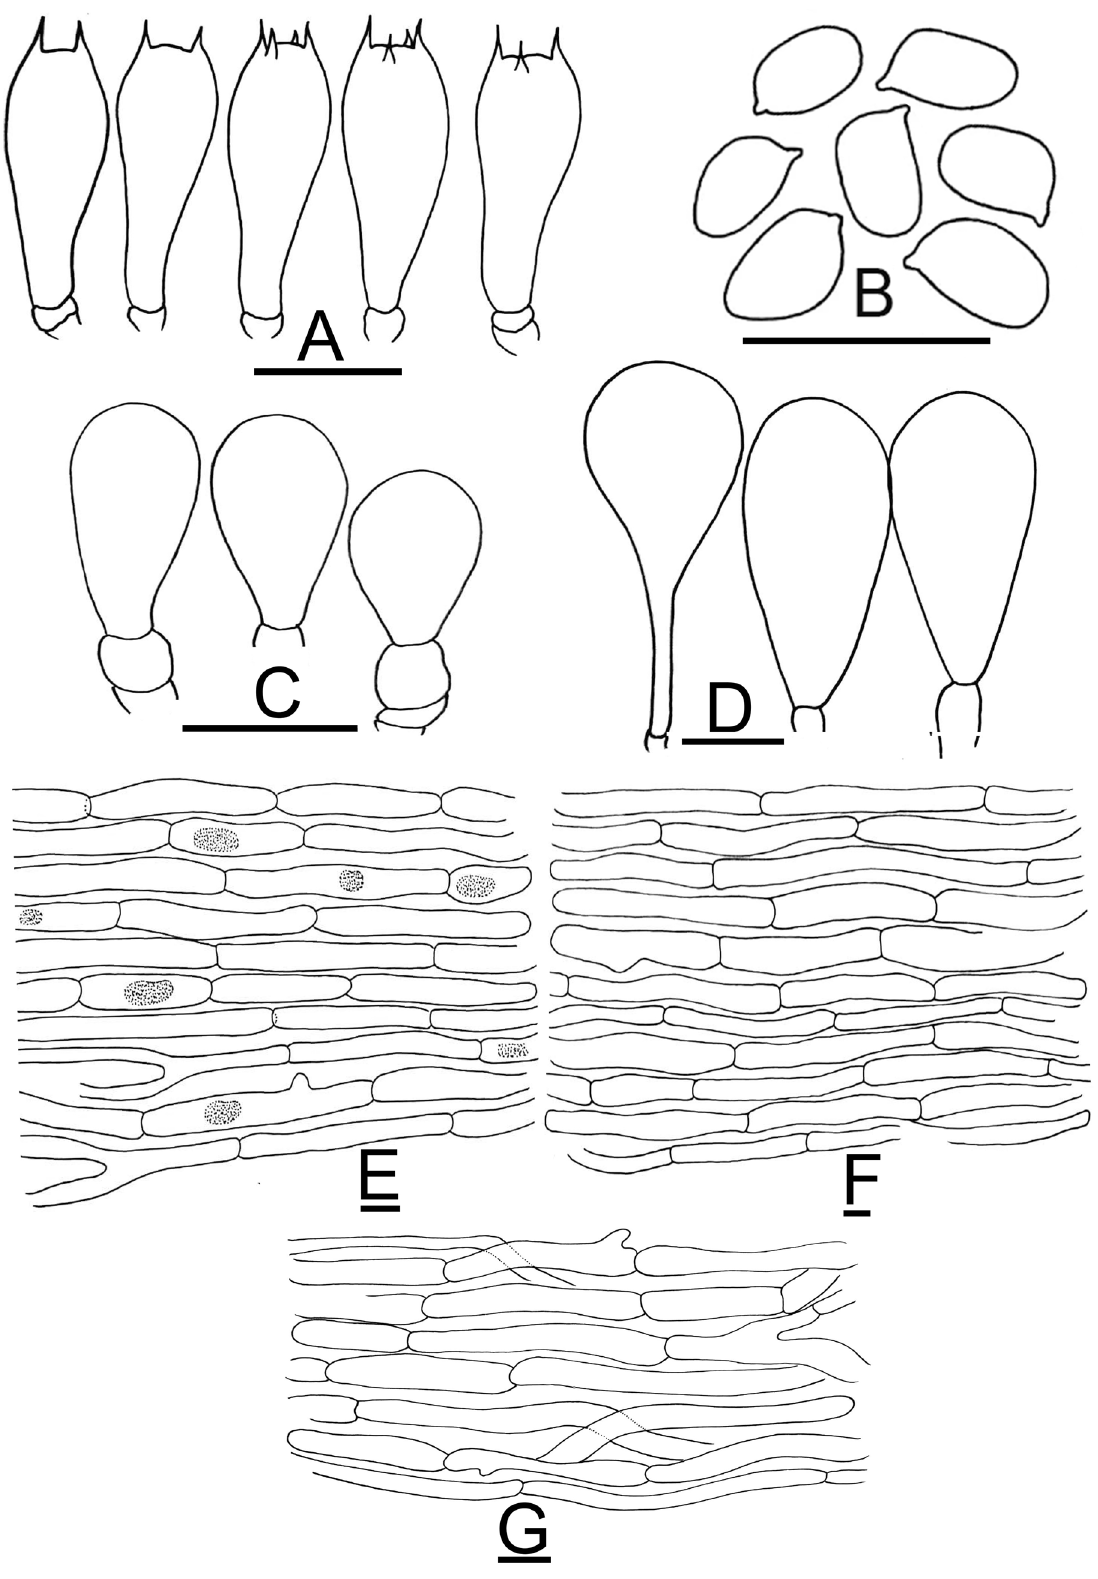
Figure 12. Micromorphological characters of A. griseovariegatus. (A–G) KH167 ( Holotype ). (A) Basidia, (B) Basidiospores, (C,D) Cheilocystidia, (E) Pileipellis hyphae, (F) Stipitipellis hyphae, (G) Hyphae of the underside of the annulus. Bars = 10 µm. Drawings by Dr. Hira